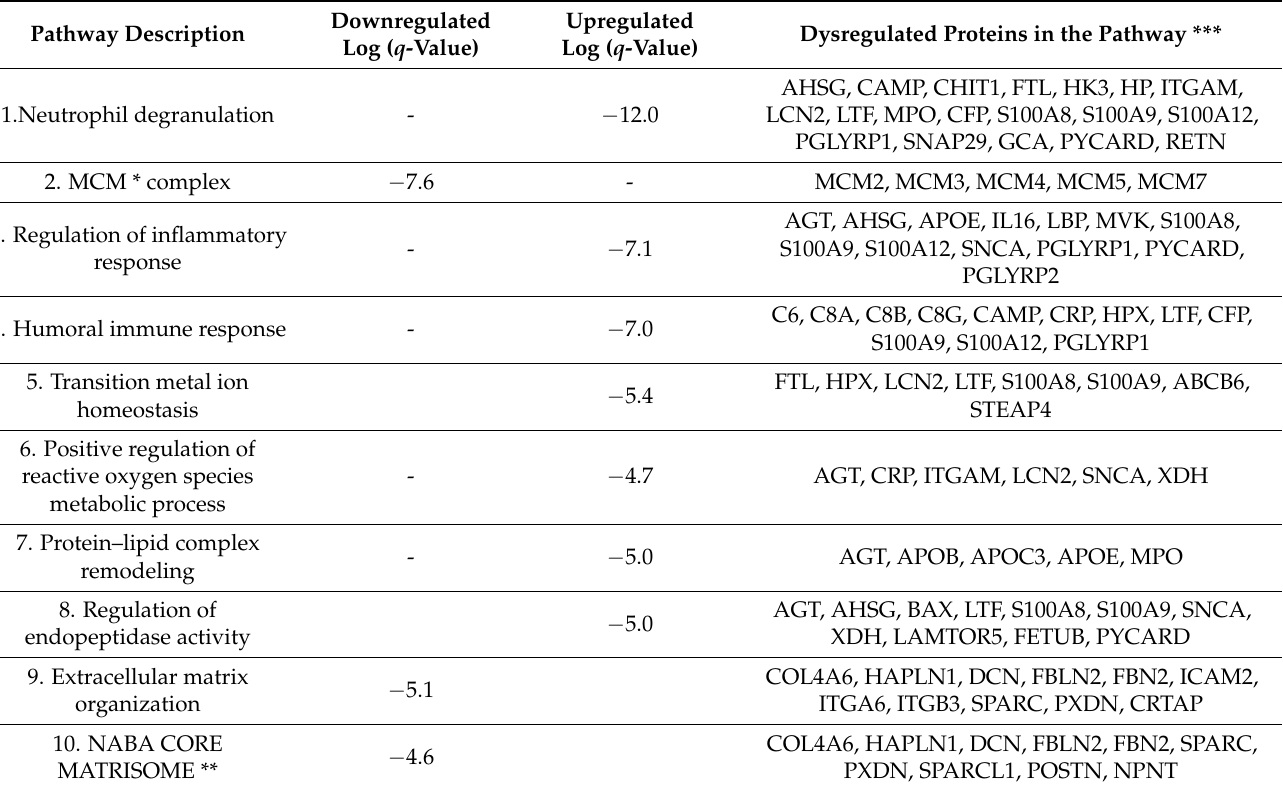
Table 3. Selected pathways significantly modulated by daily RGZ administration of 10